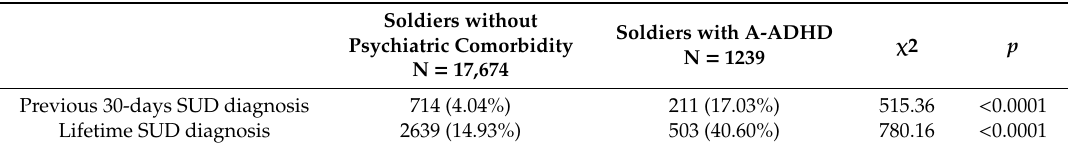
Table 2. Past-30-day and Lifetime Diagnosis of SUD in subjects with A-ADHD and without any psychiatric comorbidity.